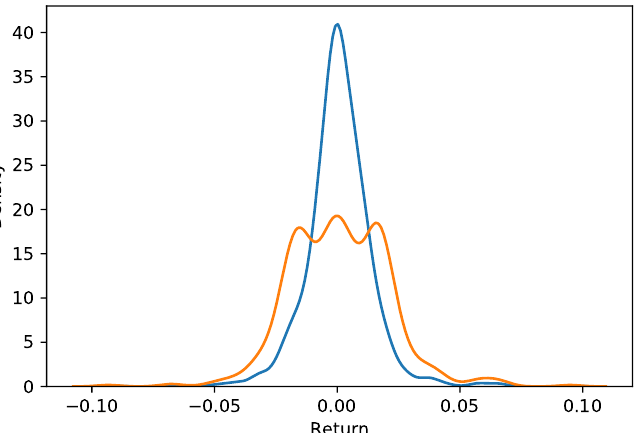
Figure 9. This figure illustrates the distribution obtained with a SMOTE regression strategy, which allows sampling elements in places where it lacks information (i.e., in the tails). It is also interesting to note that further to the generation of information in the tail, we also mechanically generate the whole market conditions associated with the data points. This figure has been obtained by applying the approach presented in Section 3.2.3 onto the Tesla